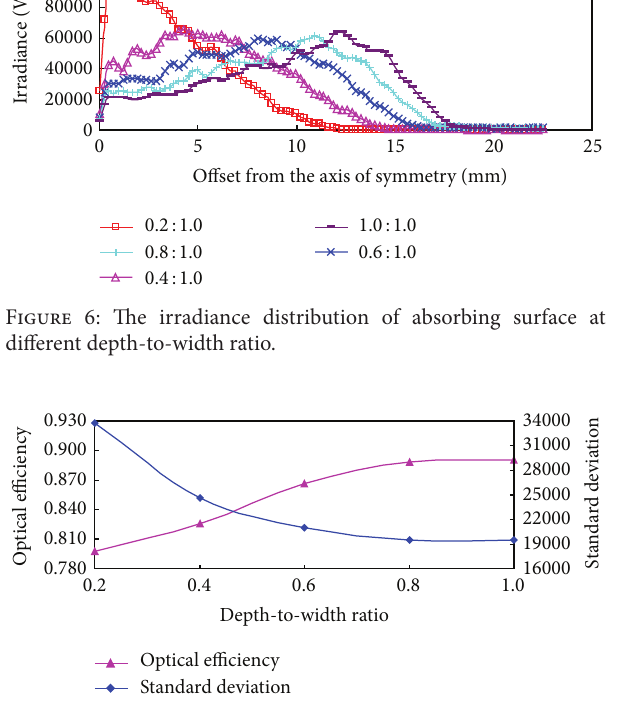
Figure7:Theopticalpropertiesofcavityatdifferentdepth-to-width ratio.